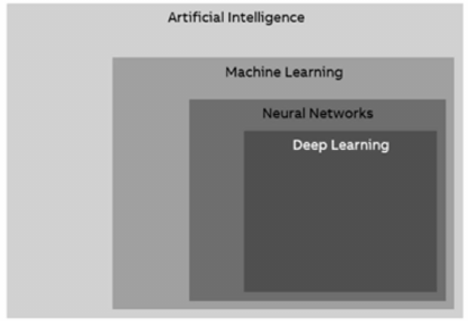
Figure 3. AI terms commonly interchanged in industrial